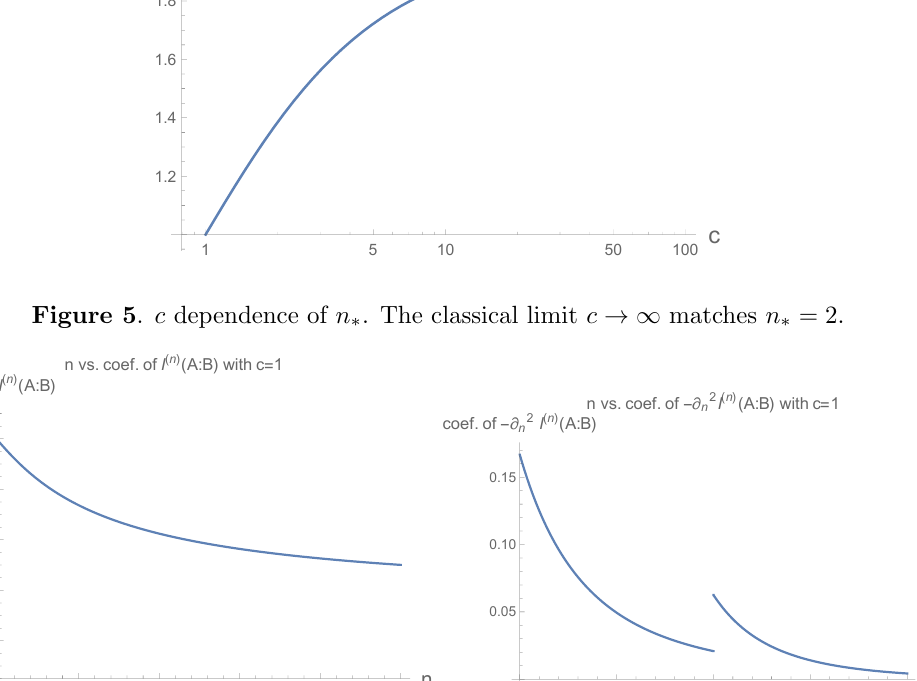
Figure 6 . The left (cid:12)gure shows the n dependence of the coe(cid:14)cient of the Renyi mutual informa- tion (3.15). It can be observed that the n ! 1 limit of the Renyi mutual information approaches I (2) ( A : B ). The right (cid:12)gure shows the n dependence of the coe(cid:14)cient of @ 2 see that @ 2 I ( n ) ( A : B ) becomes discontinuous at n = n (cid:3) n